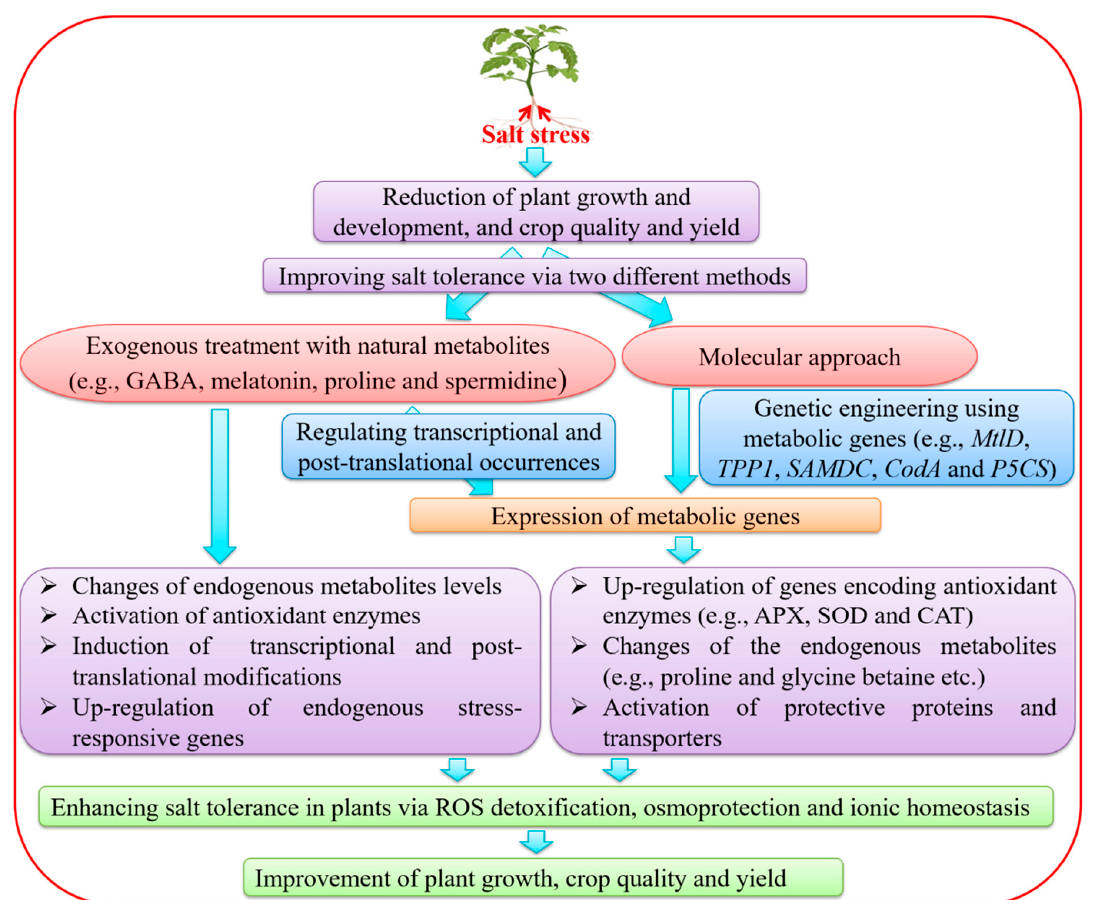
Figure 2. Approaches to improve salt tolerance via treatments with exogenous natural metabolites and genetic manipulation in plants. Treatments of plants using exogenous metabolites enhance salt tolerance by activation of antioxidant enzymes, changes of endogenous metabolites, up-regulation of stress-responsive genes and induction of transcriptional and post-translational modifications. Modulation of expression of metabolic genes in plants may lead to the improvement of salt tolerance by the up-regulation of genes encoding antioxidant enzymes and activation of transporters and protective proteins. APX, ascorbate peroxidase; CAT, catalase; CodA , choline oxidase ; GABA, γ -aminobutyric acid; MtlD , mannitol-1-phosphate dehydrogenase ; P5CS , ∆ 1 -pyrroline-5-carboxylate synthetase ; ROS, reactive oxygen species; SAMDC , s-adenosylmethionine decarboxylase ; SOD, superoxide dismutase; TPP1 , trehalose-6-phosphate synthase1